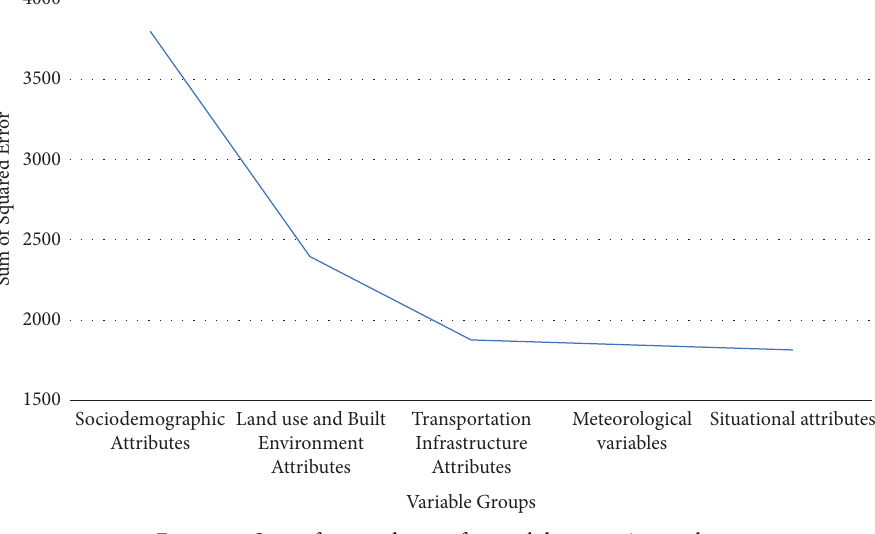
Figure 5: Sum of squared error for weekday morning peak.